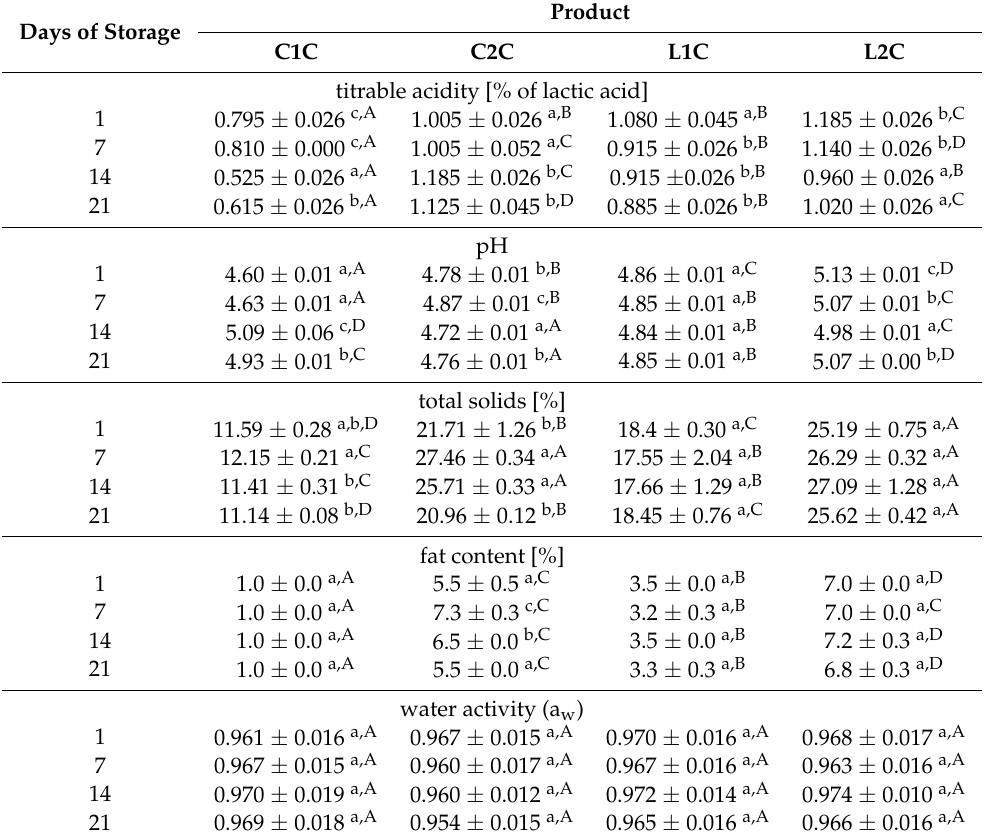
Table 1 presents physicochemical characteristics of buttermilk quark cheeses during storage. The titratable acidity was the lowest in C1C cheese from commercial buttermilk C1B (0.615–0.810% of lactic acid). Second in this parameter was L1C cheese from laboratory- obtained buttermilk with MO 242 culture. A similar range of titratable acidity had cheese C2C from commercial buttermilk C2B and cheese L2C from laboratory-obtained buttermilk with MSO culture. The percentage of lactic acid varied during the storage. Comparing the value from 1st and 21st day of storage, the titratable acidity decreased in cheese C1C, L1C and L2C. The increase was observed only in cheese C2C. The titratable acidity of buttermilk fresh cheese obtained by Bierzu´nska et al. [23] was 0.7% lactic acid, which is in the same range as cheese C1C. Table 1. Physicochemical properties of buttermilk quark cheeses during the storage. Days of Storage